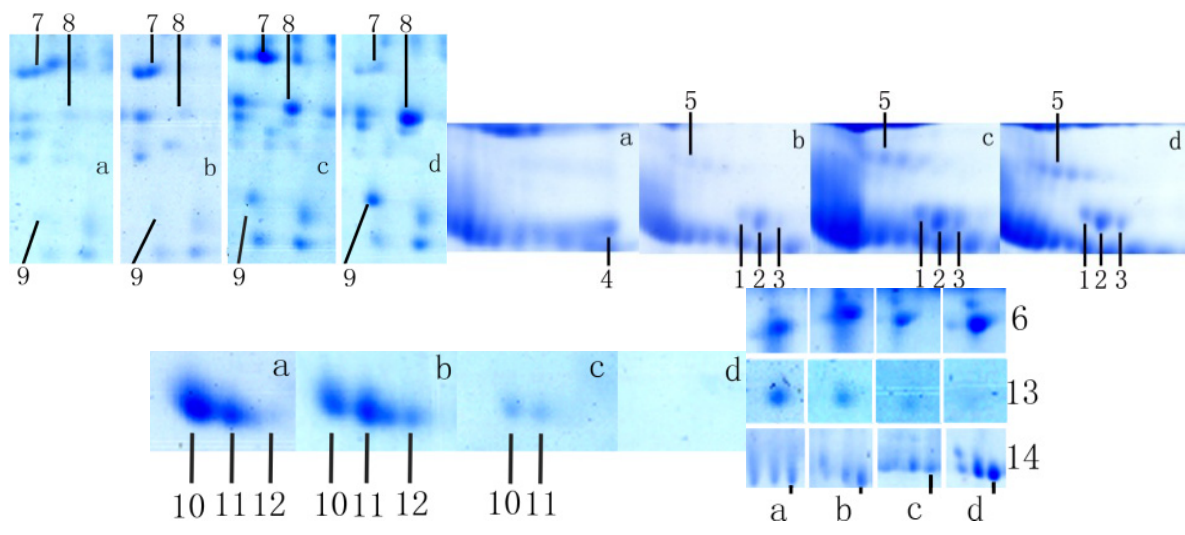
Figure 1. Two-dimensional gel electrophoresis maps of follicular fluid in Tianzhu white yak. Follicle diameter: ( a ) 0–2 mm; ( b ) 2–4 mm; ( c ) 4–6 mm; ( d ) >6 mm. 1–14 indicate the identified